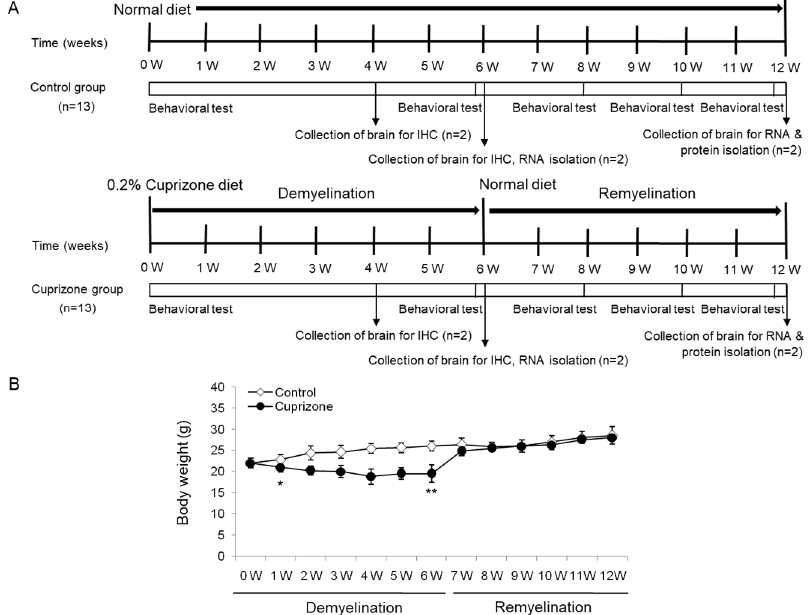
Figure 1. Schematic representation of the experimental protocols and the measurement of body weight. ( A ) The control group was fed normal chow, and two of the thirteen mice were sacrificed after 4, 6, and 12 weeks. The cuprizone group was fed a 0.2% cuprizone (CPZ) diet, and two of the thirteen mice were sacrificed after 4 and 6 weeks, respectively. The CPZ group was fed the CPZ-containing diet for 6 weeks and then allowed to recover for 6 weeks on normal chow without CPZ. Behavior assessments were conducted in the two groups at 0, 6, 8, 10, and 12 weeks during the experimental period, and two of the nine mice were sacrificed at 6 weeks after CPZ withdrawal, respectively. ( B ) The body weight of the mice was measured weekly throughout the experimental period. The final data was made with the results of the total individuals minus the number of sacrificed mice. N = 7 for each group, and * p < 0.05, ** p < 0.01.